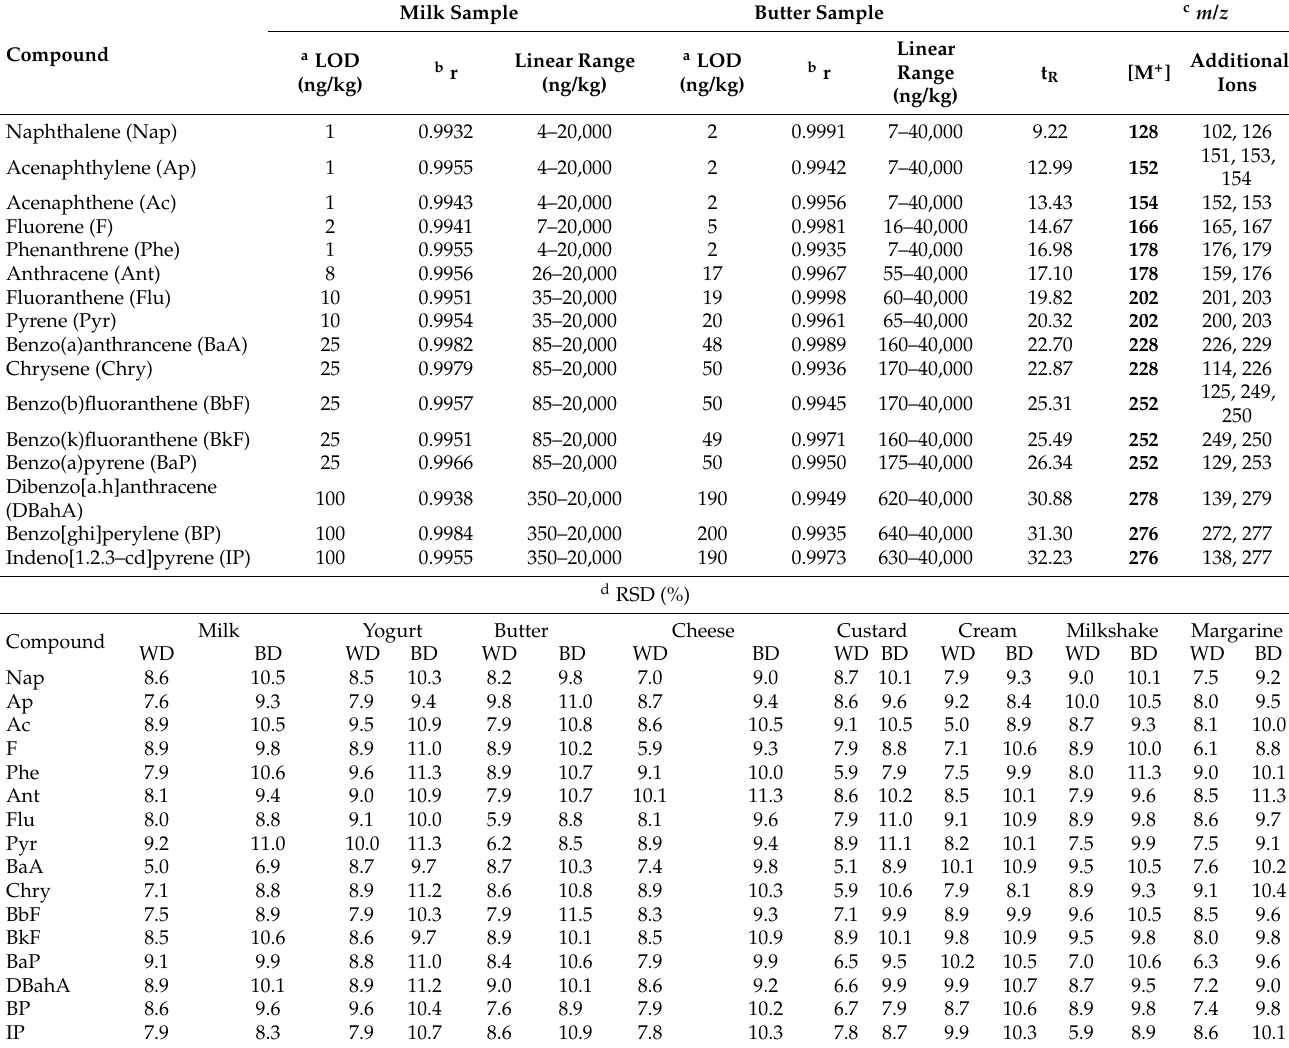
Table 2. Analytical characteristics of the determination of PAHs in milk and dairy products by the proposed